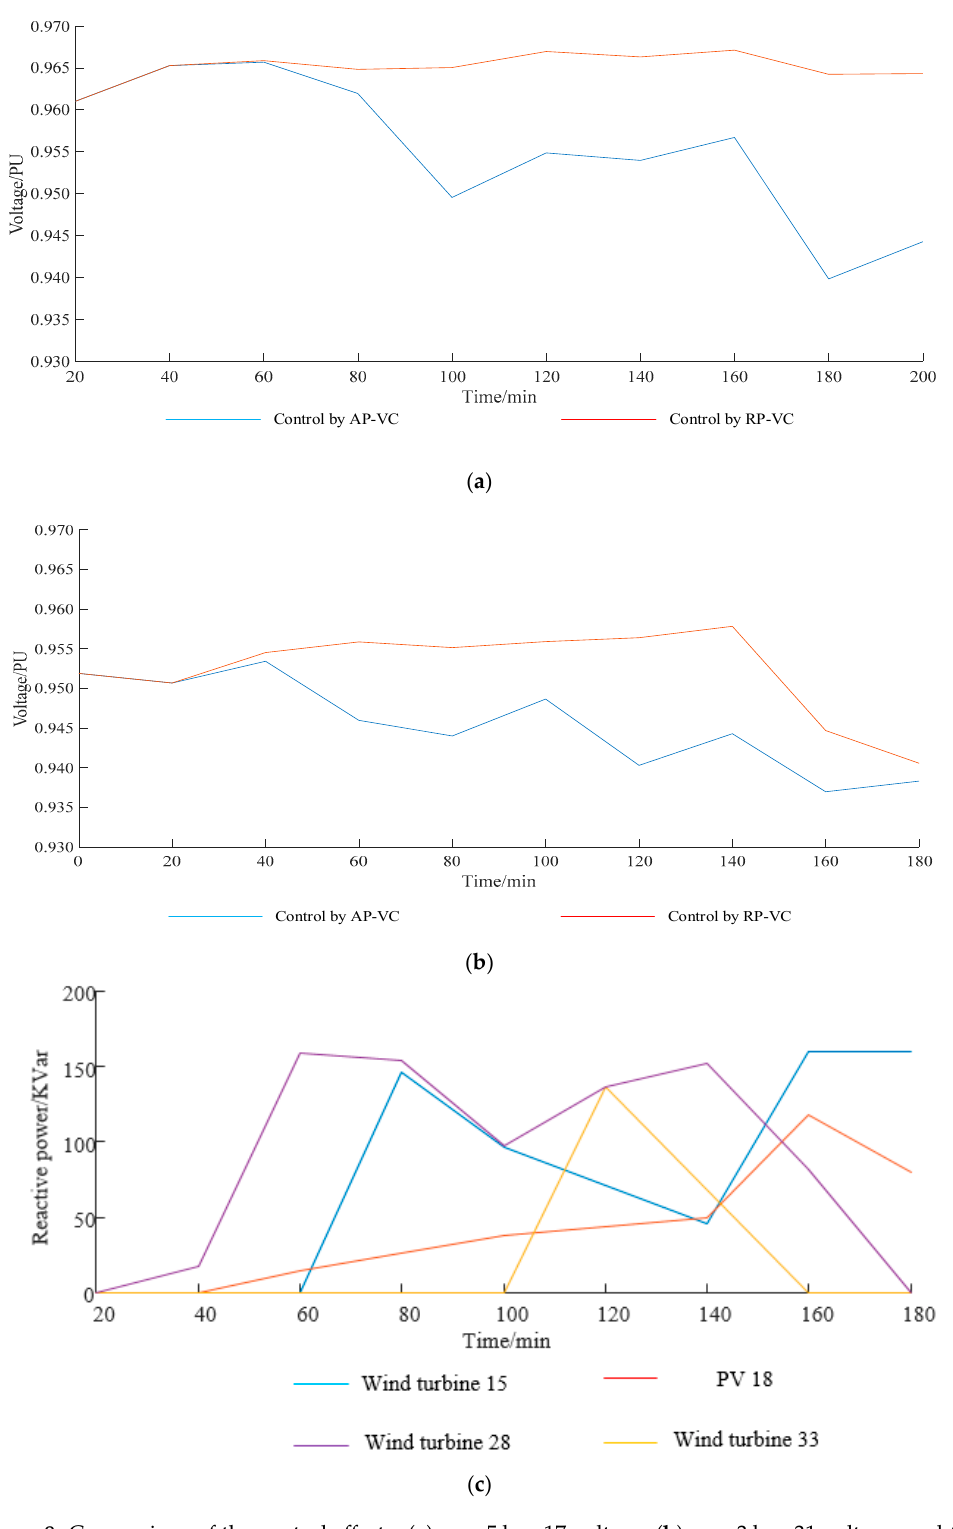
Figure 8. Comparison of the control e ff ects: ( a ) area 5 bus 17 voltage; ( b ) area 3 bus 31 voltage; and ( c ) wind power and PV reactive power